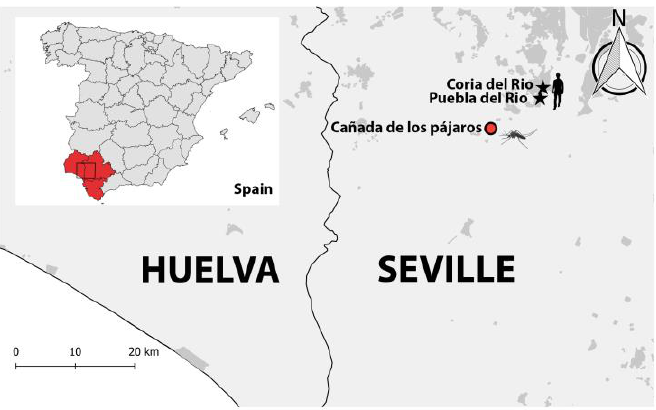
Figure 1. Map showing the three provinces of Andalusia where human and equine cases occurred during 2020 and 2021 (Huelva, Seville and Cadiz). In the main map, the stars represent the two sites in Seville that concentrated most of the cases during 2020 and 2021 season. The red circle is the location where the mosquito pools used for whole genome sequencing were captured. The dark gray areas are the cities and